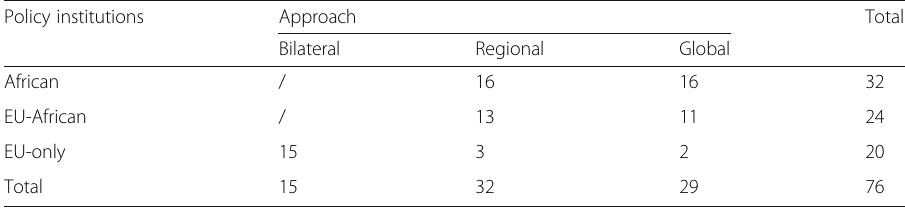
Table 1 Overview of Documents used for the content analysis Policy